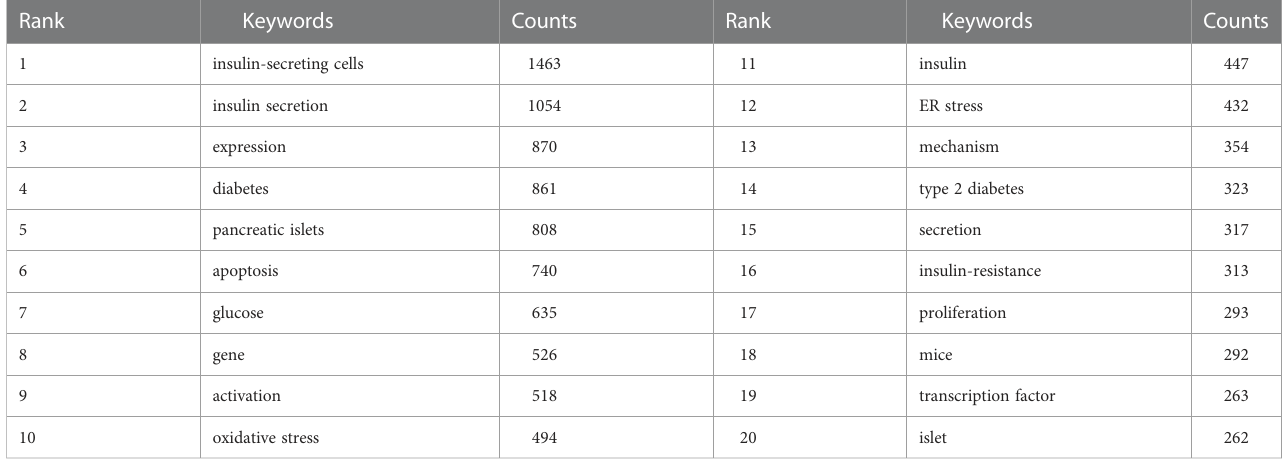
TABLE 6 Top 20 keywords of beta-cell